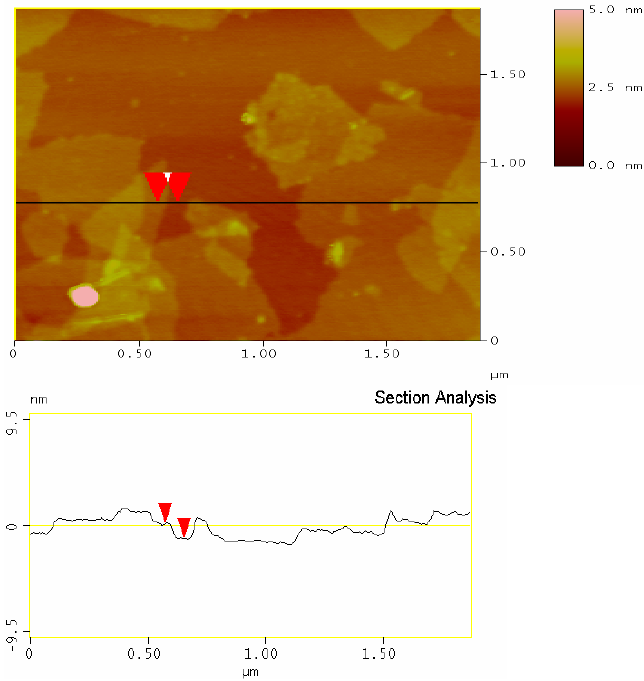
Figure 10. Atomic force microscopy (AFM) image of GS1.